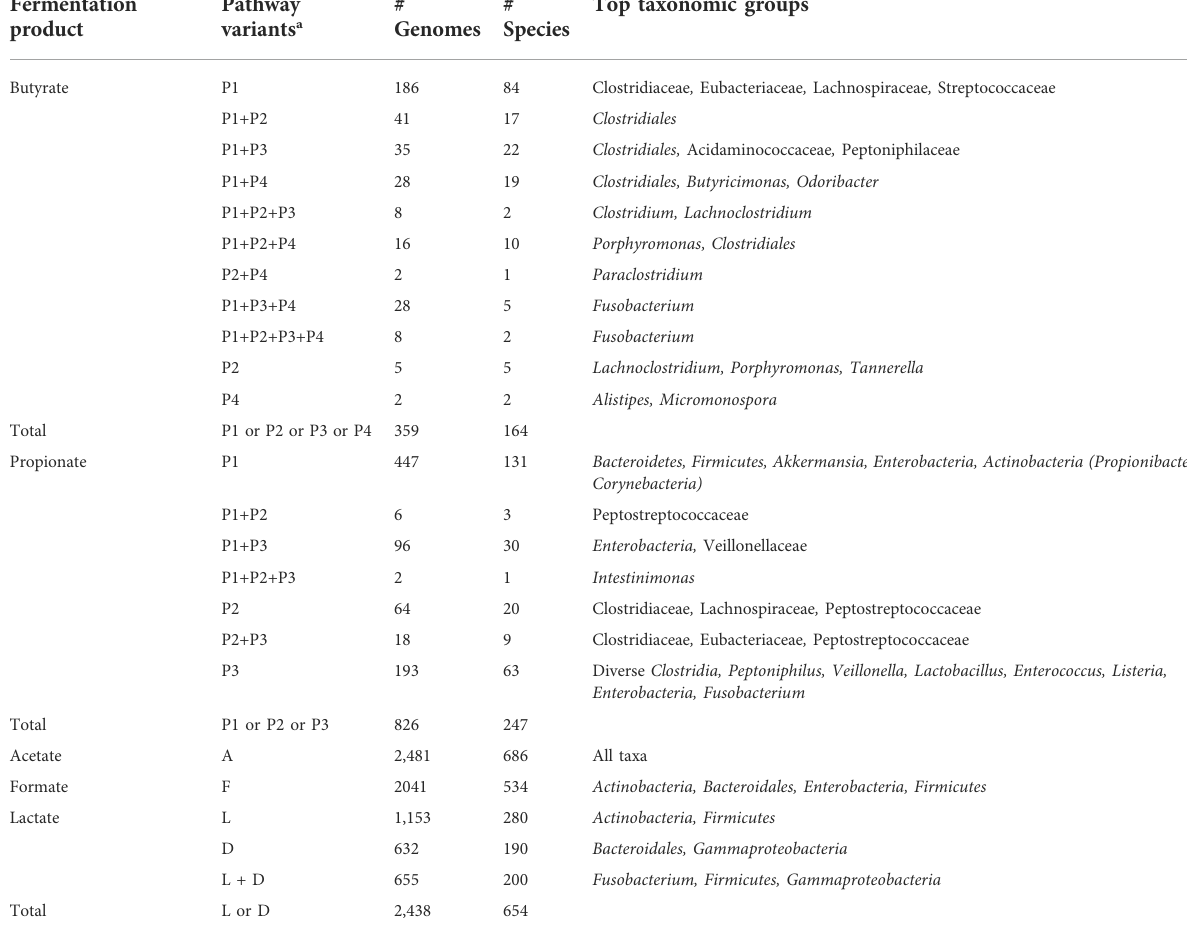
TABLE 1 The distribution of SCFA production pathways in the HGM reference genomes. Fermentation Pathway product variants